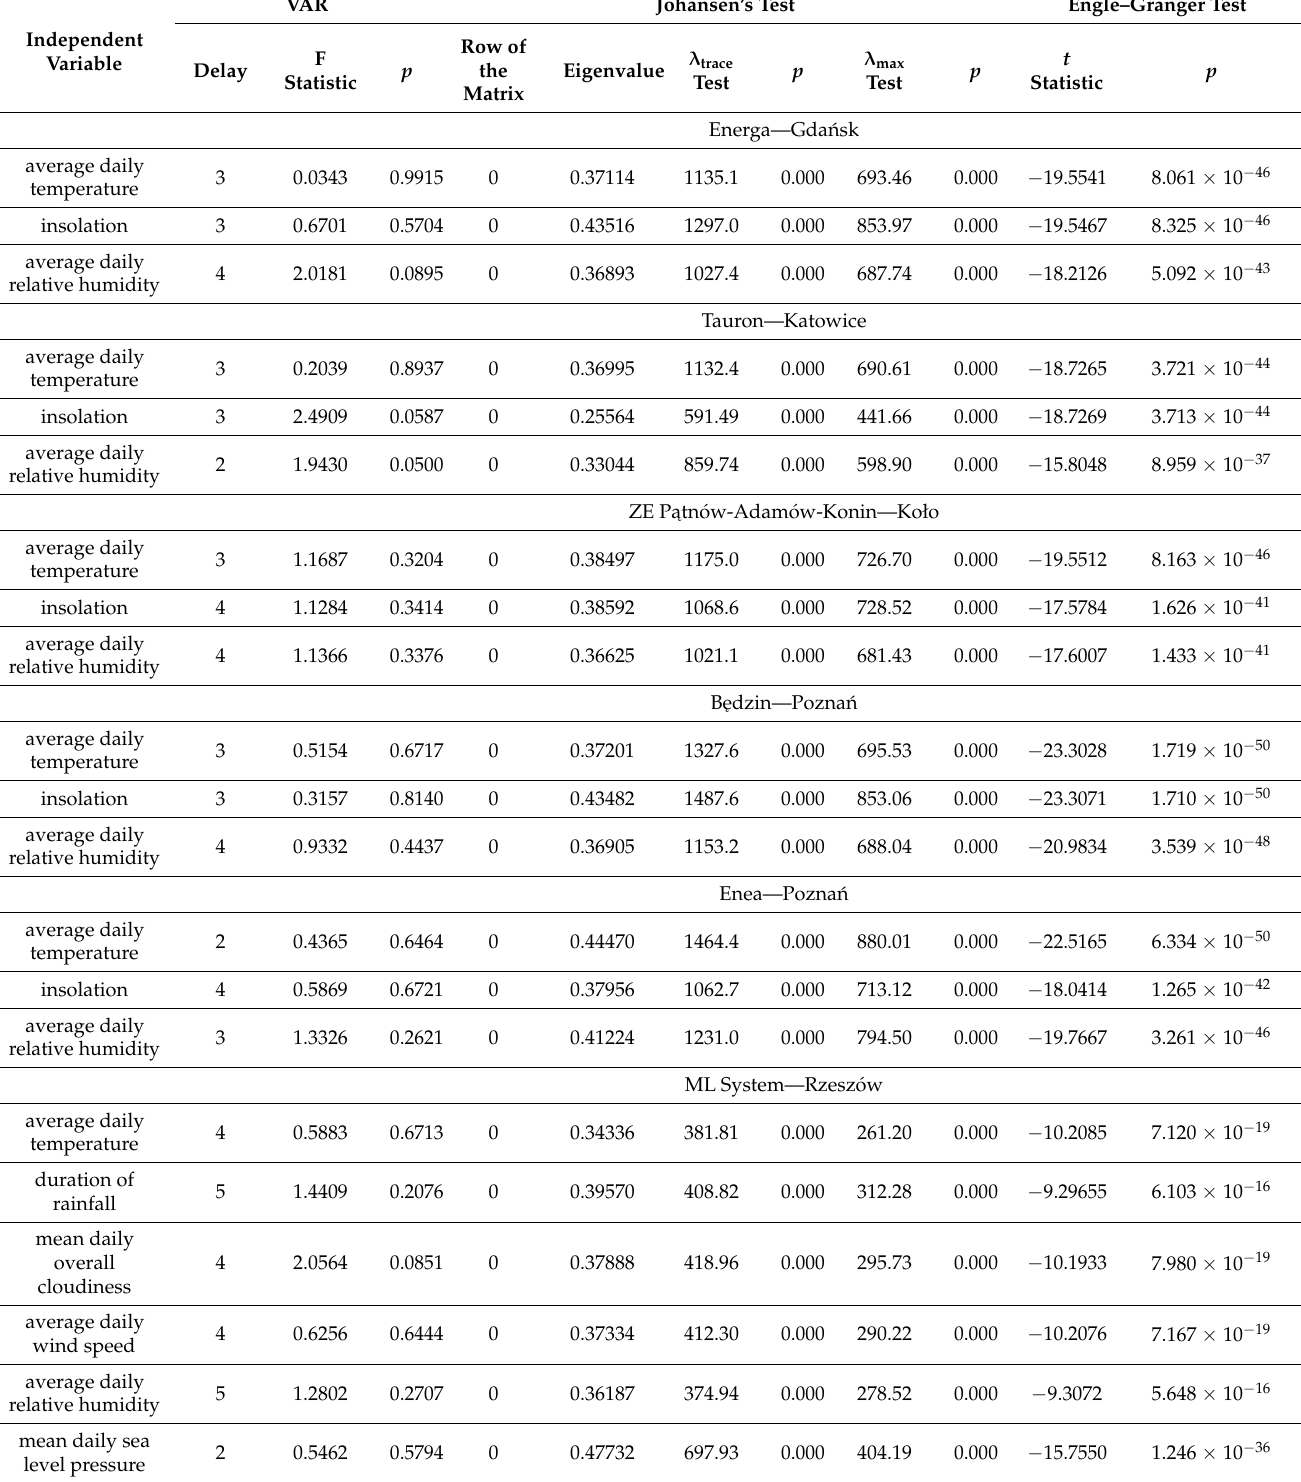
Table 7. VAR causality test results for the rate of return and non-stationary weather factors along with co-integration analysis. VAR Johansen’s